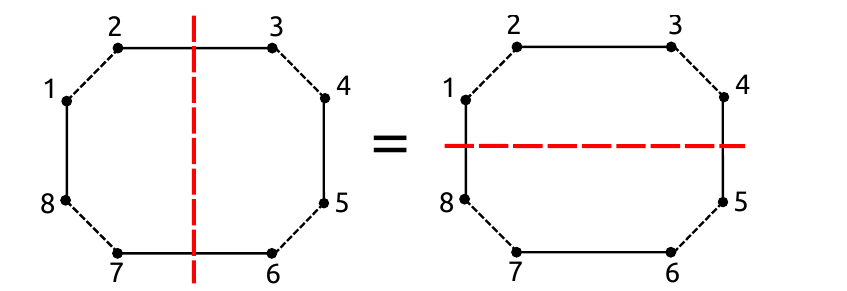
Figure 4: Di ff erent cuts of the 4-point vertex give the same